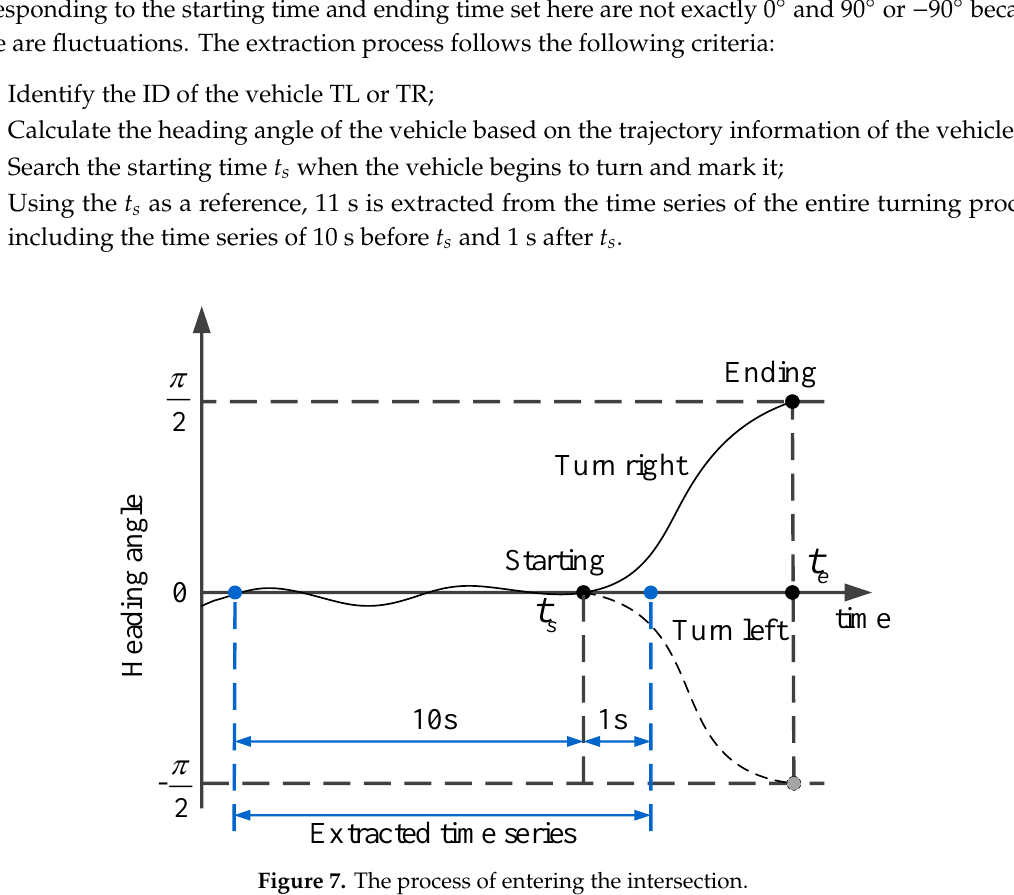
Figure 7. The process of entering the intersection.